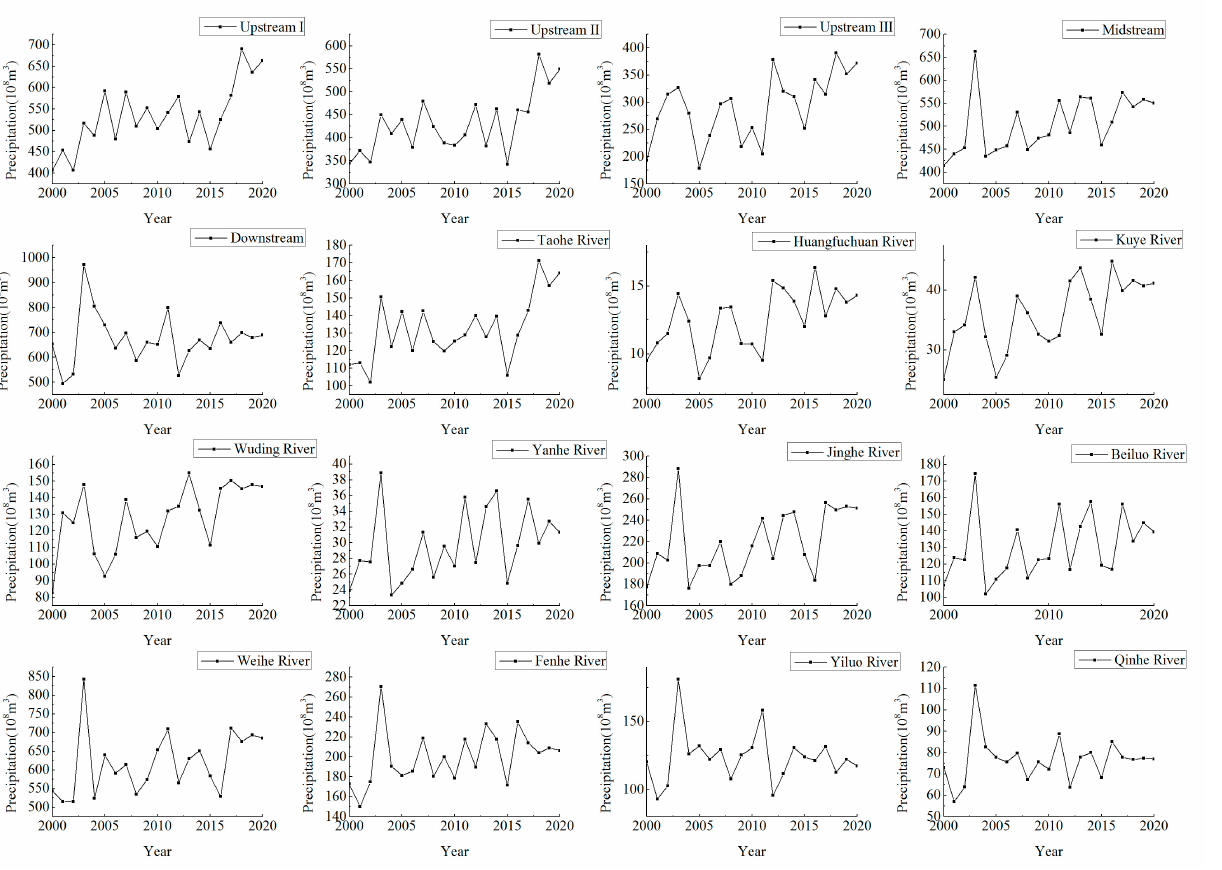
Figure 4. Dynamic changes in precipitation in the Yellow River basin; this figure includes the change of runoff in each division of the main stream and main